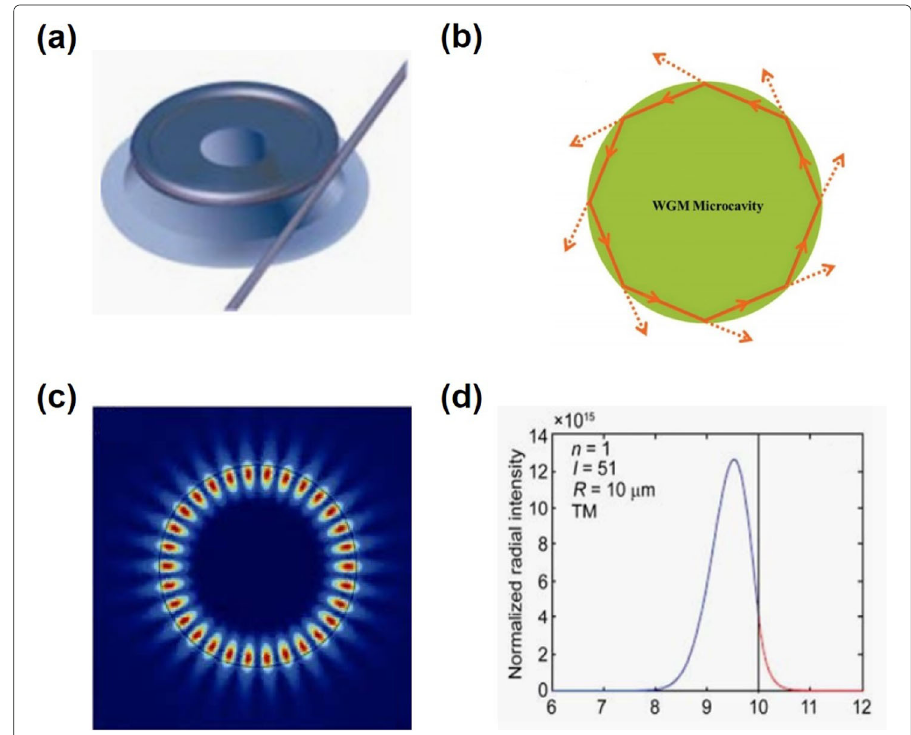
Fig. 2 The basic concepts of WGMs. a Schematic of WGM toroid microcavity [3]. b Schematic of self-reinforced light by total internal reflection [69]. c The typical electric field distribution of WGM in a microsphere [70]. d The radial field distribution of mode shown in ( c ) [70]. The x -axis in ( d ) represents radius distance from center, and the unit is μ